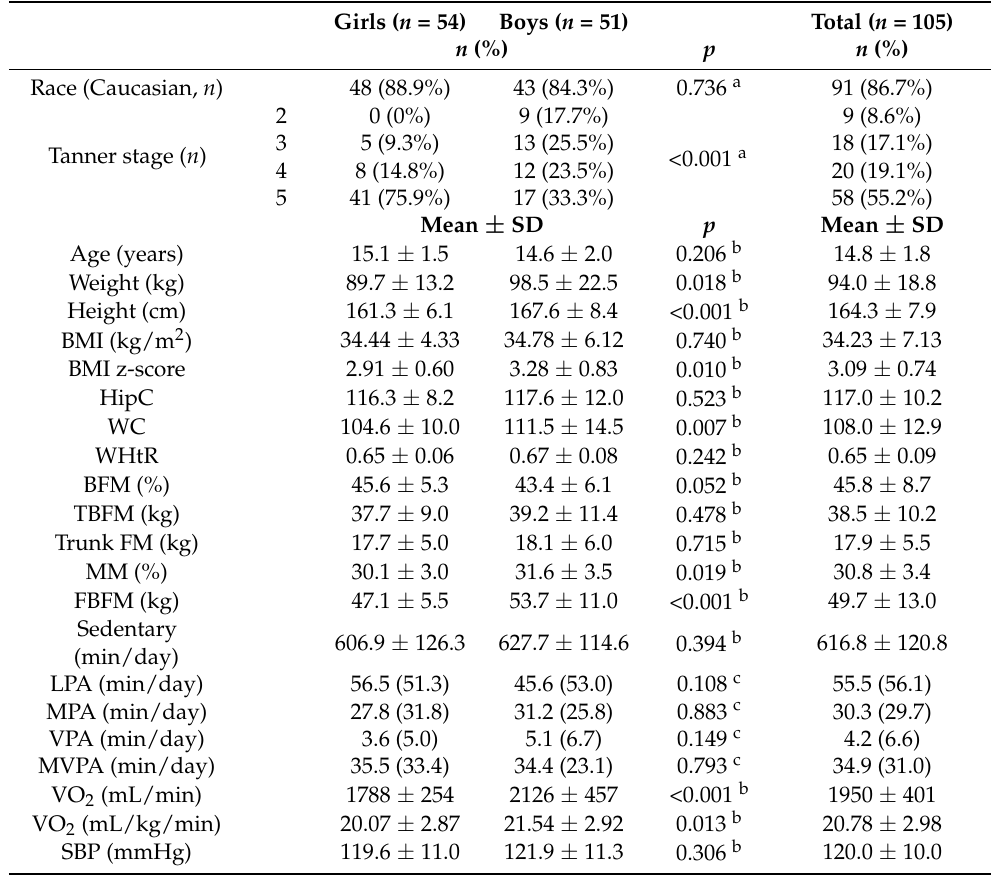
Table 1. Participants’ characteristics at